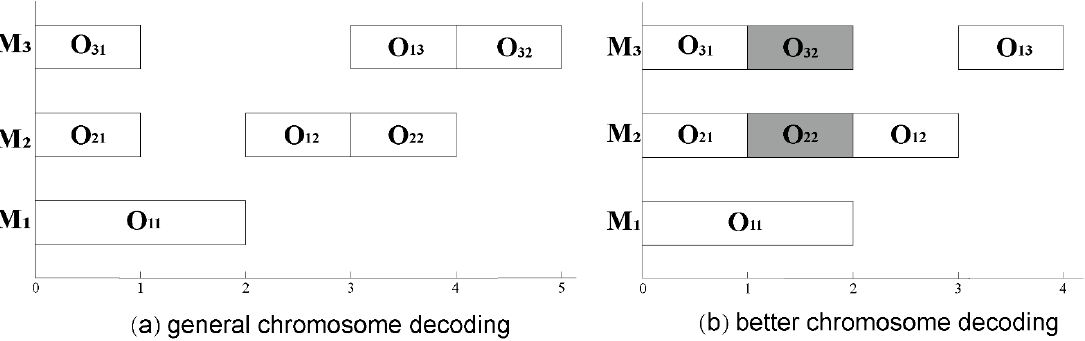
Figure 1. Chromosome decoding corresponds to the Gantt chart.